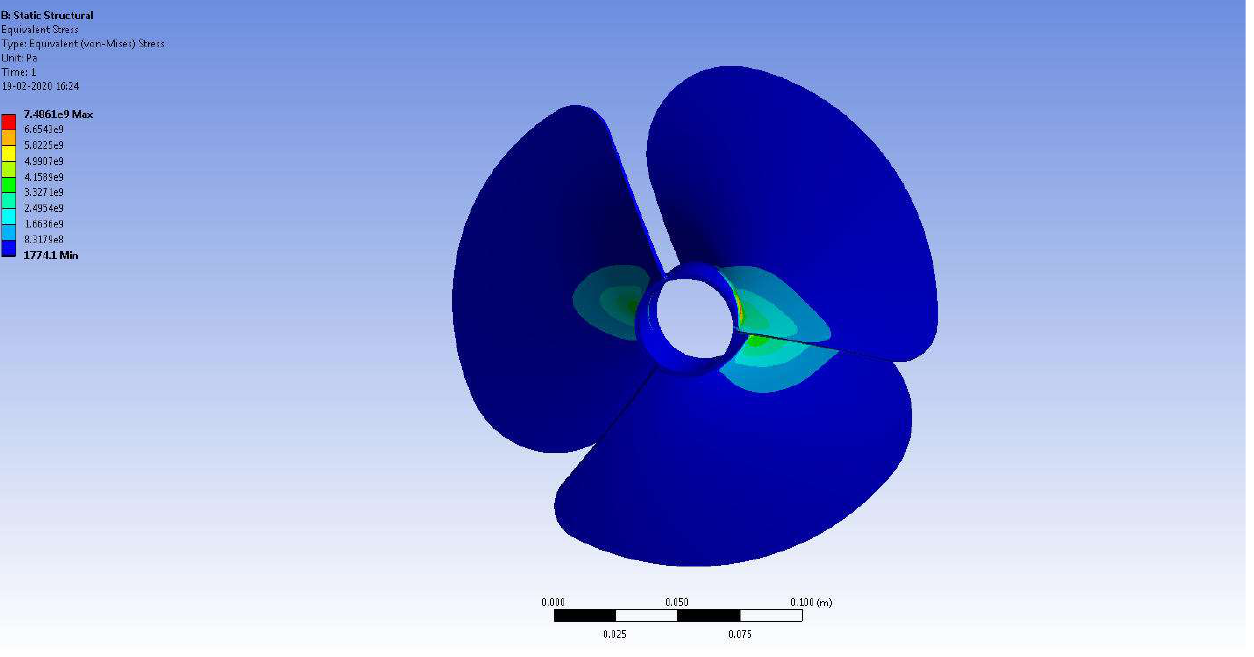
Figure 24. Equivalent Stress variation at 300 m depth with 20 m/s fluid velocity—CFRP—UD—Prepreg—230